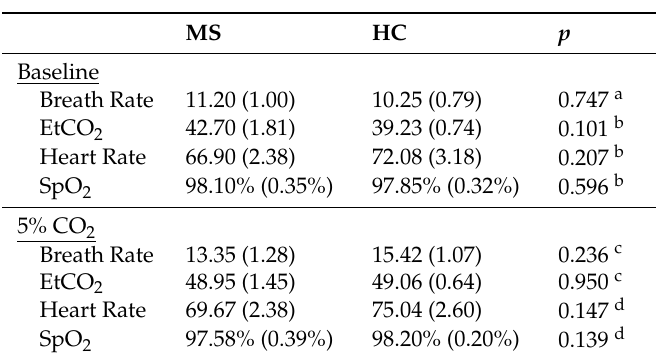
Table 3. Sample Physiological